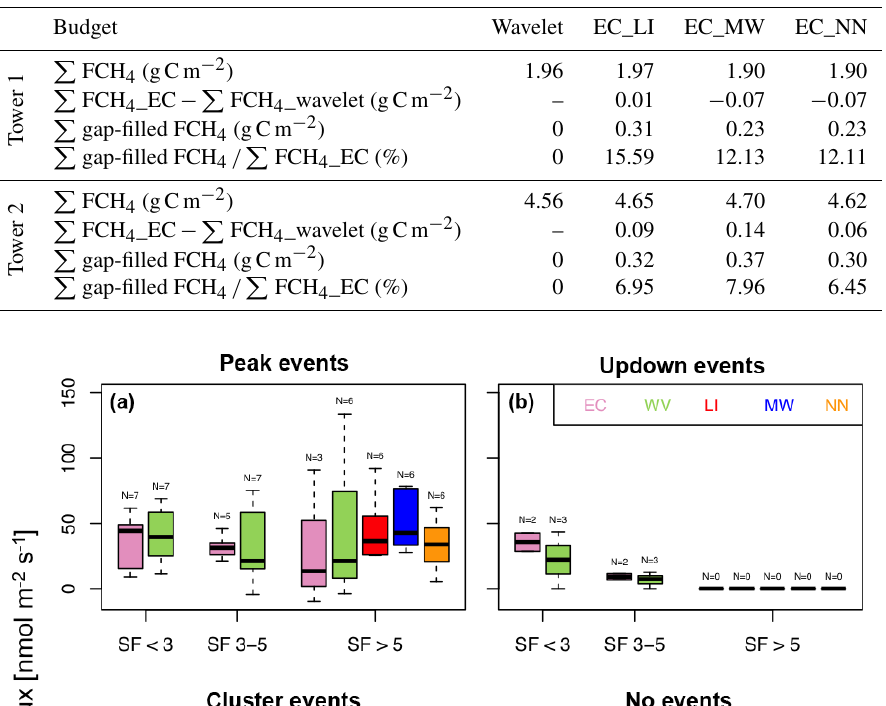
Table 4. Methane fluxes (FCH 4 ) summed up for the wavelet method and EC method by applying the three different gap-filling approaches: linear interpolation (LI), moving window (MW) and neural network (NN). Note that the same gaps as for the fluxes based on the wavelet method are used for the EC-flux time series.